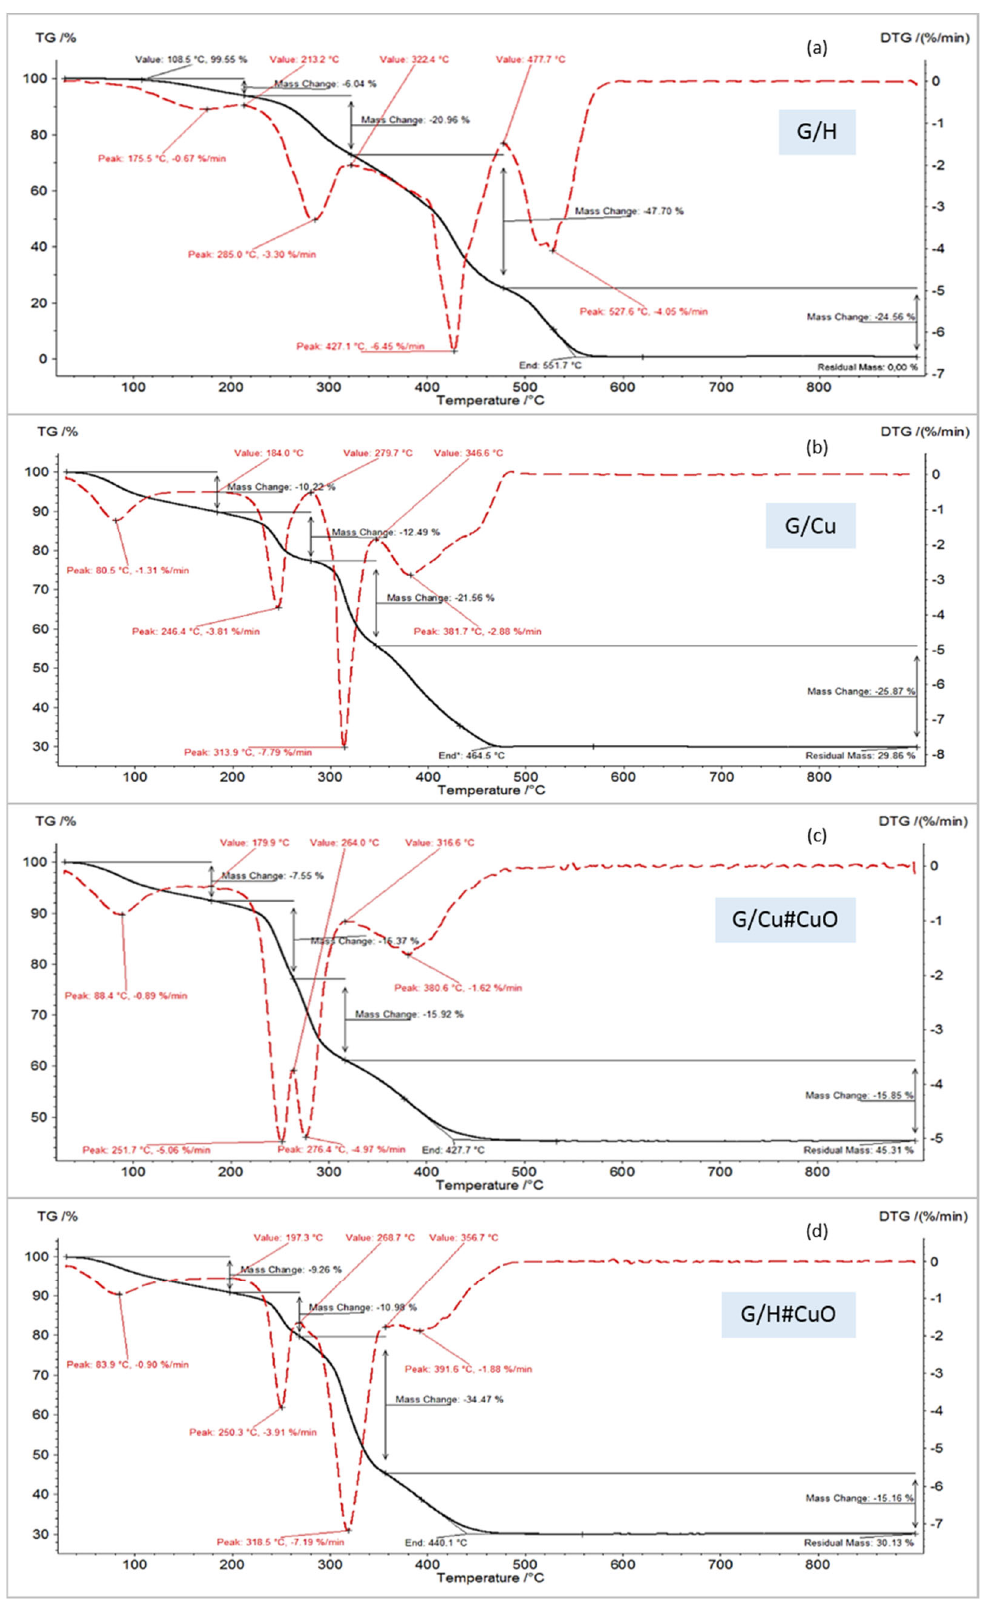
Figure 4. TG/DTG curves in air of ( a ) G/H, ( b ) G/Cu, ( c ) G/Cu#CuO, and ( d ) G/H#CuO.